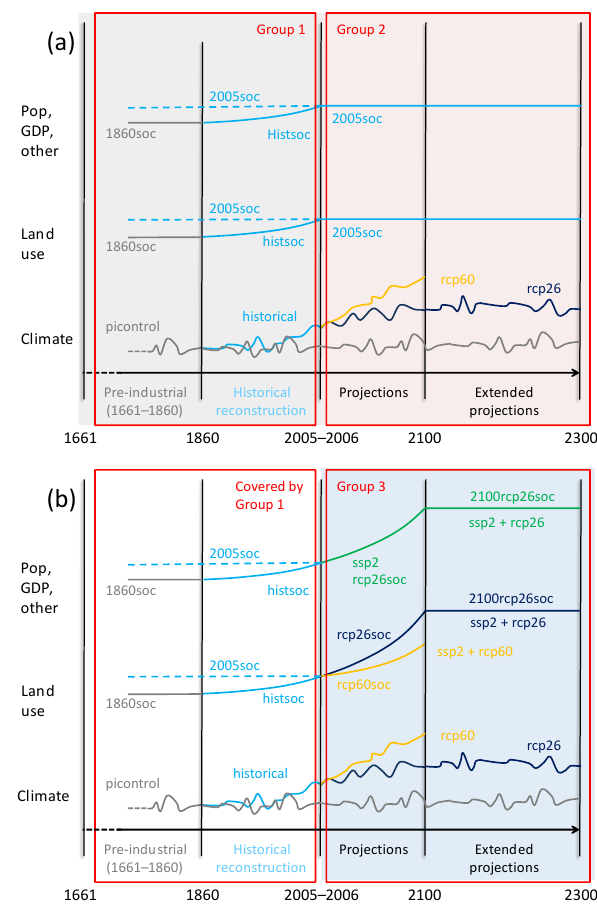
Figure 1. Schematic representation of the scenario design for ISIMIP2b. “Other” includes other non-climatic forcing factors such as fertilizer input, irrigation, selection of crop varieties, flood pro- tection levels, dams and reservoirs, water abstraction for human use, fishing effort, atmospheric nitrogen deposition, etc. Panel (a) shows the Group 1 and Group 2 runs. Group 1 consists of model runs to separate the pure effect of the historical climate change from other (human) influences. Models that cannot account for changes in a particular forcing factor are asked to hold that forcing factor at 2005 levels (2005soc, dashed lines). Group 2 consists of model runs to es- timate the pure effect of the future climate change assuming fixed year 2005 levels of population, economic development, LU, and management (2005soc). Panel (b) shows Group 3 runs. Group 3 consists of model runs to quantify the effects of the LU changes, and changes in population, GDP, and management from 2005 on- wards associated with RCP6.0 (no mitigation scenario under SSP2) and RCP2.6 (strong mitigation scenario under SSP2). Forcing fac- tors for which no future scenarios exist (e.g. dams/reservoirs) are held constant after